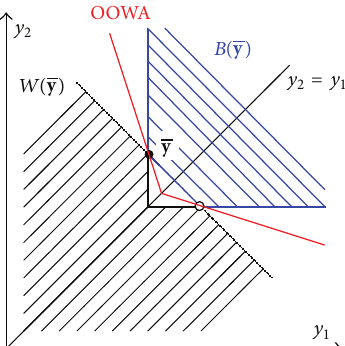
Figure 2: The fair dominance structure and the ordered OWA optimization.